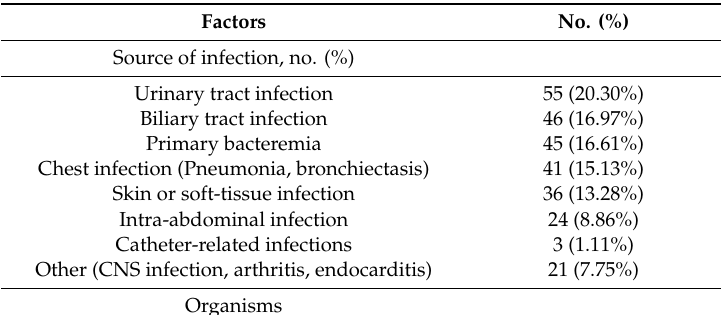
Table 1. Sources of infection and organisms in patients presenting with bacteremia at the emergency department ( n = 271).